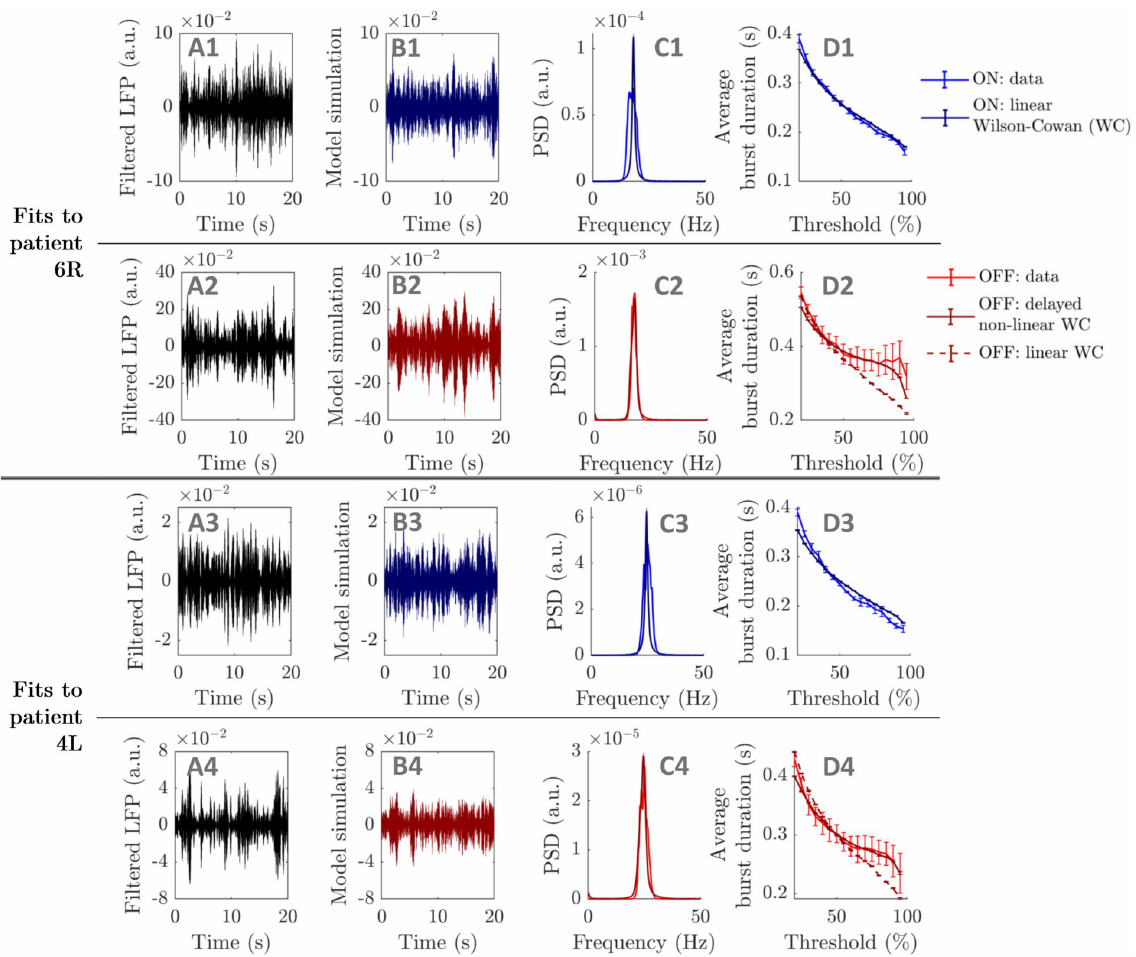
Fig 7. Best WC model fits. Showing best fits to datasets 6R (ON: first row, OFF: second row), and 4L (ON: third row, OFF: fourth row). The first column shows twenty seconds of filtered LFP recording (A panels), while the same duration of model oscillatory activity output is plotted in the second column (B panels). Data and model PSDs are compared in the third column (C panels), and data and model average burst duration profiles are shown in the last column (D panels, SEM error bars). In the first and third rows, all model outputs correspond to fits of the linear WC model. In the second and fourth rows, dark red solid lines correspond to fits of the delayed non-linear WC model, and dark red dashed lines to fits of the linear WC model (shown for comparison, D panels only).